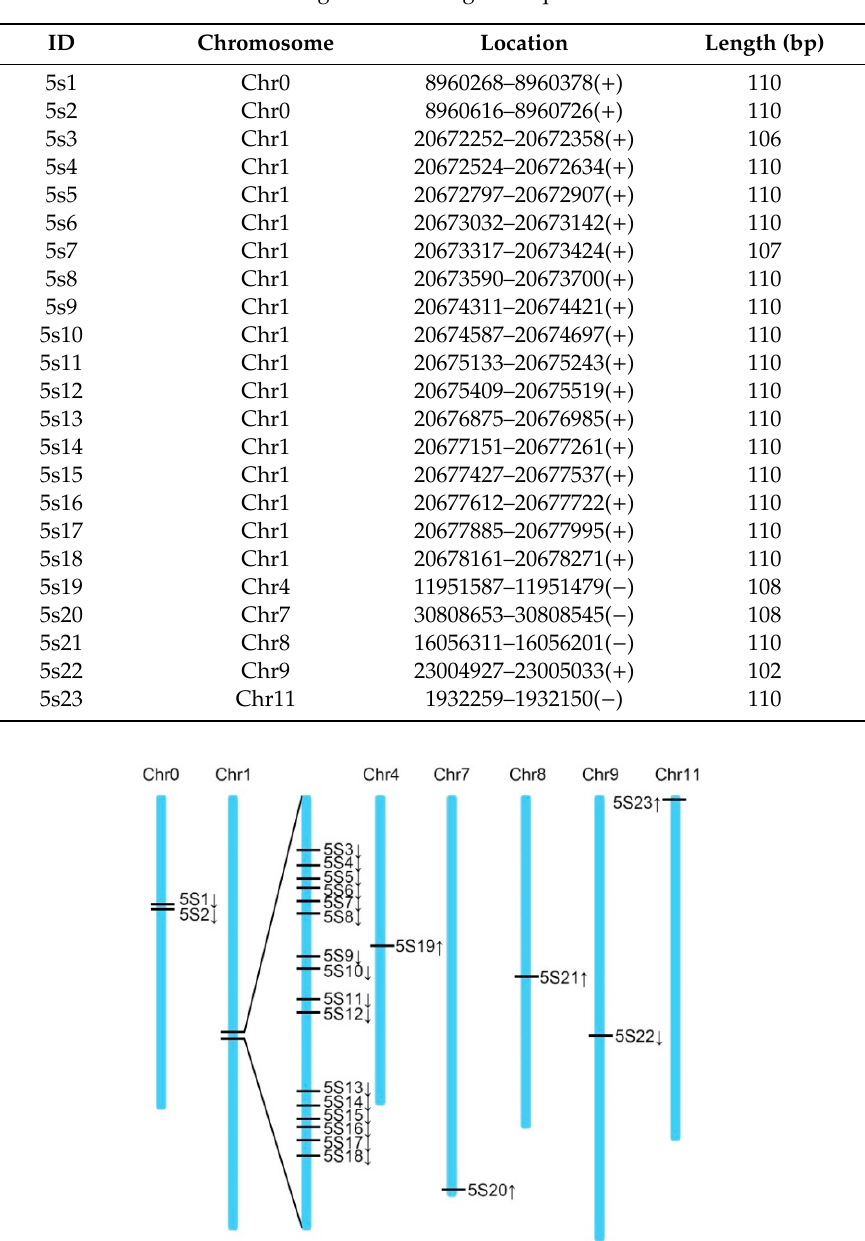
Table 2. 5S rDNA fragment homologous sequence information.